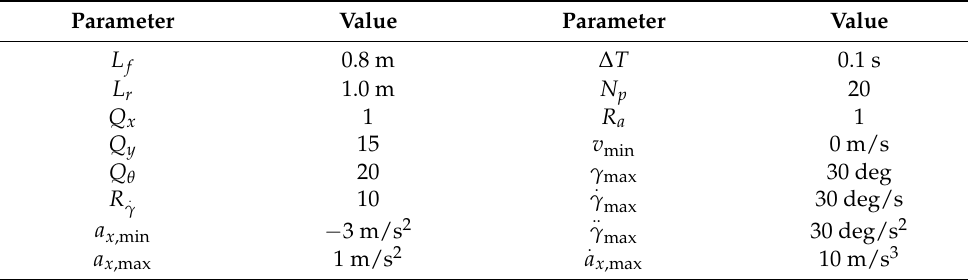
Table 1. Parameters for AAEV and MPC-based reference state tracker. Parameter